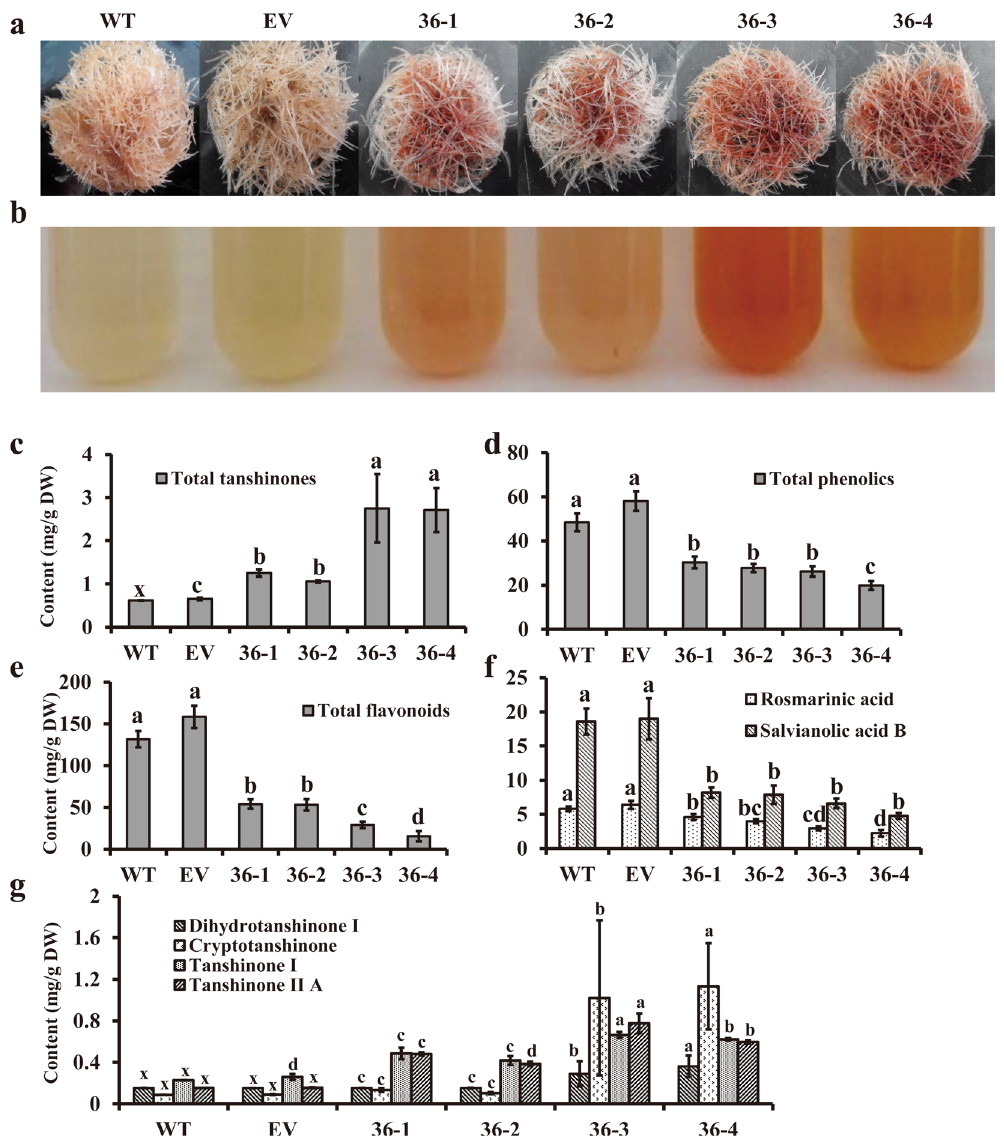
Figure 5. The phenotypes of hairy roots. ( a ) Hairy roots of S. miltiorrhiza induced by A. rhizogenes strain ATCC15834. Hairy roots were cultured in 6,7-V liquid medium for 18 days before being photographed. ( b ) The colour differences between different extracts of dry hairy roots. ( c ) The content of total tanshinones in hairy roots. ( d ) The content of total phenolics in hairy roots. ( e ) The content of total flavonoids in hairy roots. The pictures show WT (infected by A. rhizogenes strain ATCC15834), EV (infected by A. rhizogenes strain ATCC15834 containing plasmid pK7WG2R-EV), line 36-1, line 36-2, line 36-3 and line 36-4 (infected by A. rhizogenes strain ATCC15834 containing plasmid pK7WG2R-SmMYB36) hairy roots from left to right. ( f ) The content of dihydrotanshinone I, cryptotanshinone, tanshinone I and tanshinone II A in transgenic and control hairy roots of S. miltiorrhiza . The x represents the values calculated by standard curves when the peak area is zero (18 days). ( g ) The content of rosmarinic acid and salvianolic acid B in transgenic and control hairy roots of S. miltiorrhiza . The physiological and HPLC analysis both have three biological repeats of transgenic lines and each biological repeat has three technological repeats. The metabolite contents were shown by their means ±